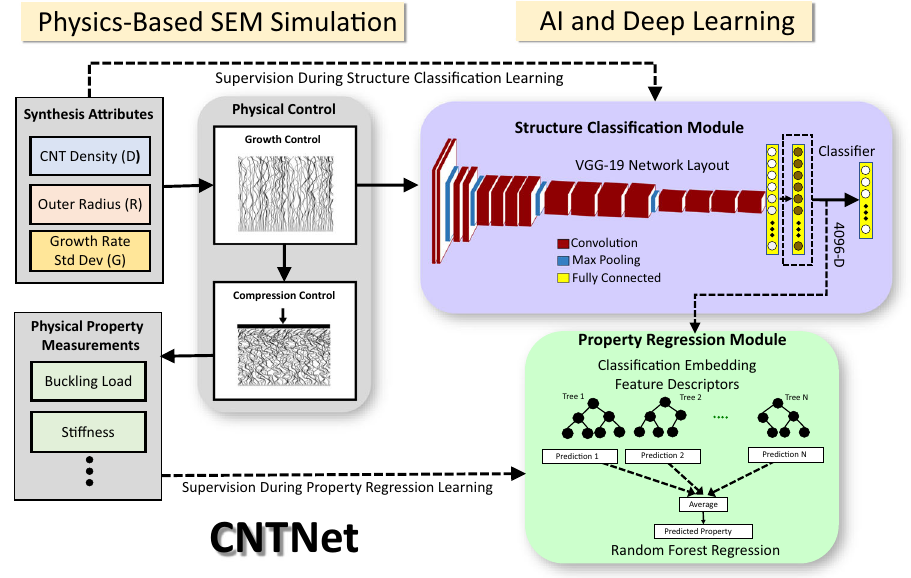
Fig. 5 Schematic of CNTNet modules. CNTNet is a modular image-based machine learning and control framework for enabling arti fi cial intelligence-driven classi fi cation of CNT forest synthesis attribute groups and predictions of CNT forest material properties. The top structure classi fi cation module uses the VGG-19 deep learning network for classifying CNT forests into one of 63 CNT classes based on combinations of synthesis attributes generating different CNT forest simulated SEM image classes. The structure classi fi cation network captures morphological texture properties and was trained using transfer learning with initialization using ImageNet weights. The bottom property regression module uses random forest regression trees to learn CNT forest buckling load and stiffness by mapping the 4096-D feature image representation descriptor using 2D regression vector functions.